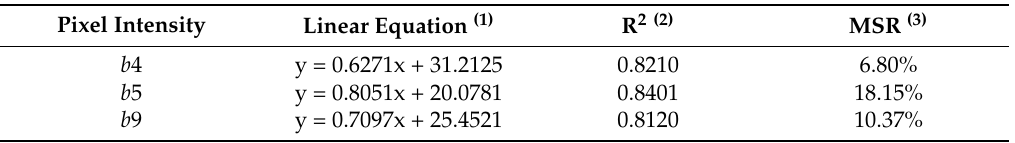
Table 2. Linear regression between known LANDSAT 8 (OLI) pixel intensity and the prediction from the proposed ANN